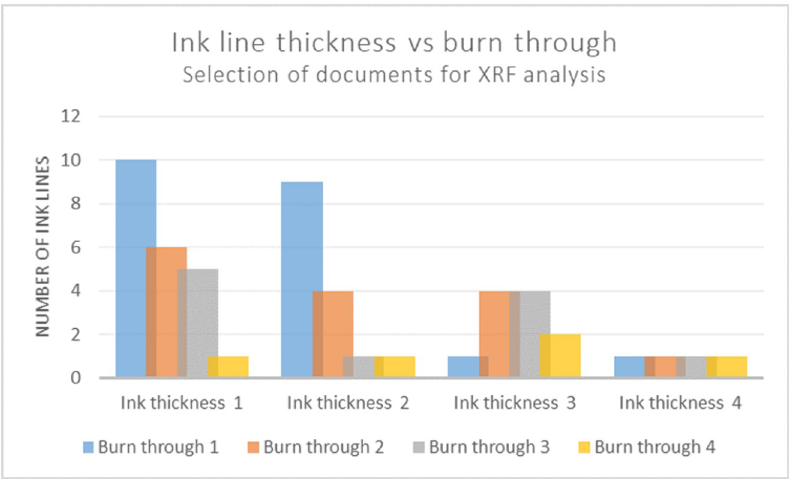
Fig 17. Burn through in relation to ink line thickness of 24 documents for XRF analysis. Y-axis displaying number of ink lines of specified ink thickness, 1–4, and burn through, 1–4.